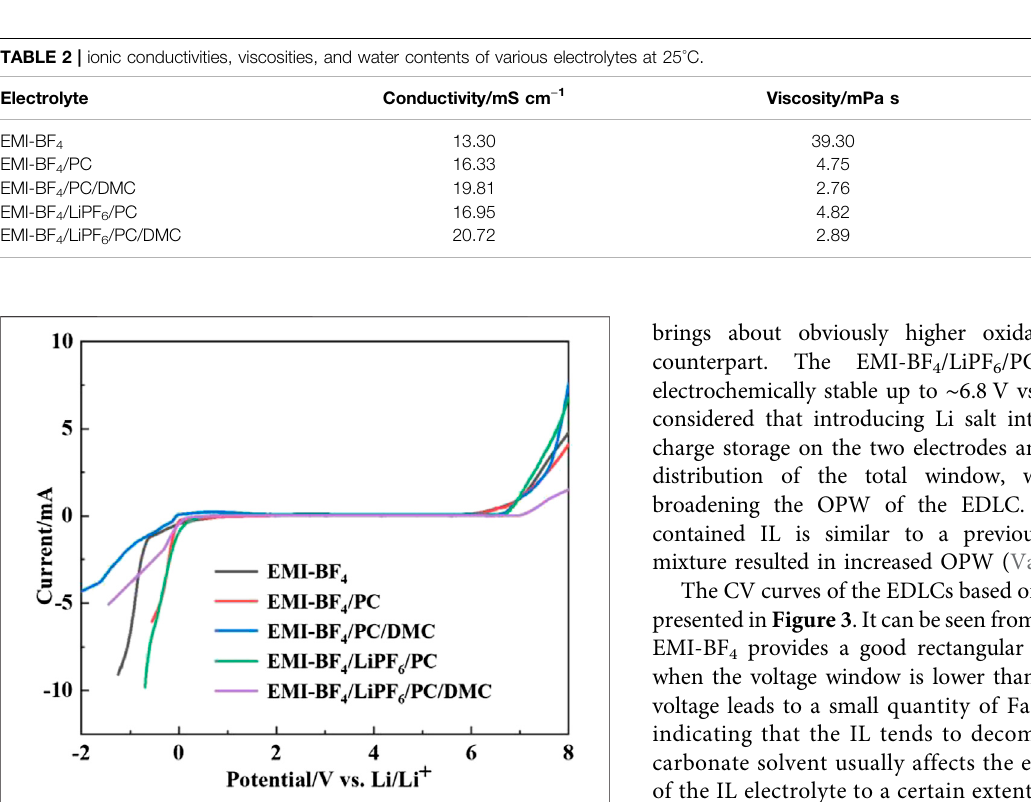
FIGURE 2 | LSV curves of SS/Li cell in various electrolytes between − 2 and 8 V vs. Li/Li + .